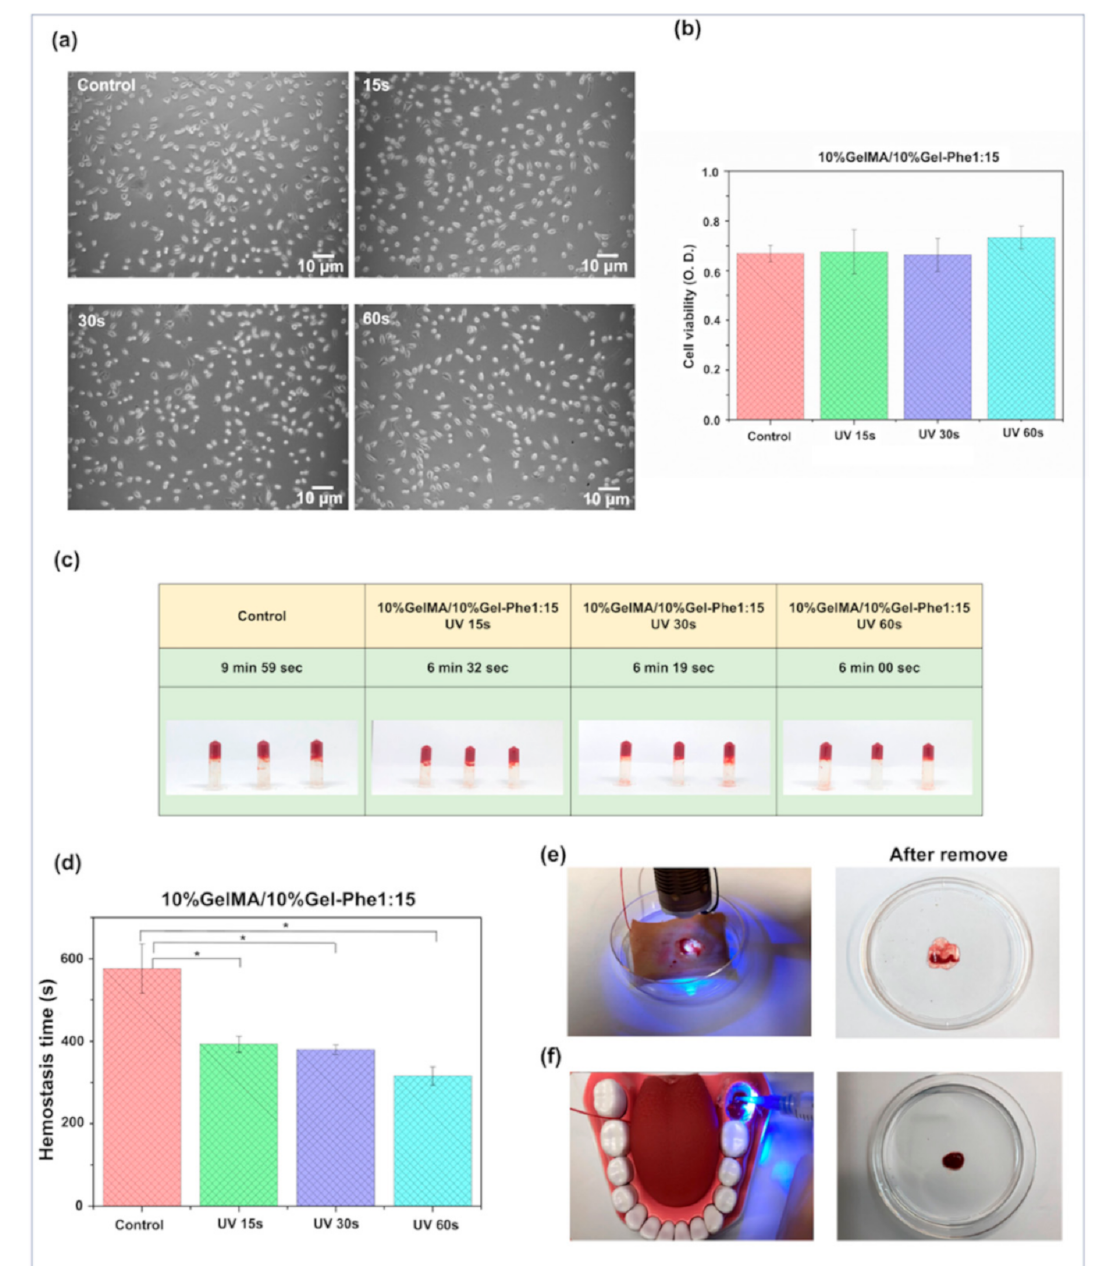
Figure 4. Validation of the hemostatic function of GelMA/Gel-Phe bioadhesives. ( a ) The cell morphology and ( b ) cell viability of the L929 cells treated with the extraction medium from the GelMA/Gel-Phe bioadhesives with different UV exposure times. ( c ) The in vitro blood clotting test and ( d ) the hemostasis times of GelMA/Gel-Phe bioadhesives with different UV exposure times. * p < 0.05. ( e ) The in vitro porcine skin and ( f ) tooth extraction bleeding models for mimicking the 10%GelMA/10%Gel-Phe1:15 bioadhesive under a blood perfusion. The images show that the bioadhesive had a rapid hemostatic effect within the 60 s of UV light exposure and could be easily removed from the bleeding site after